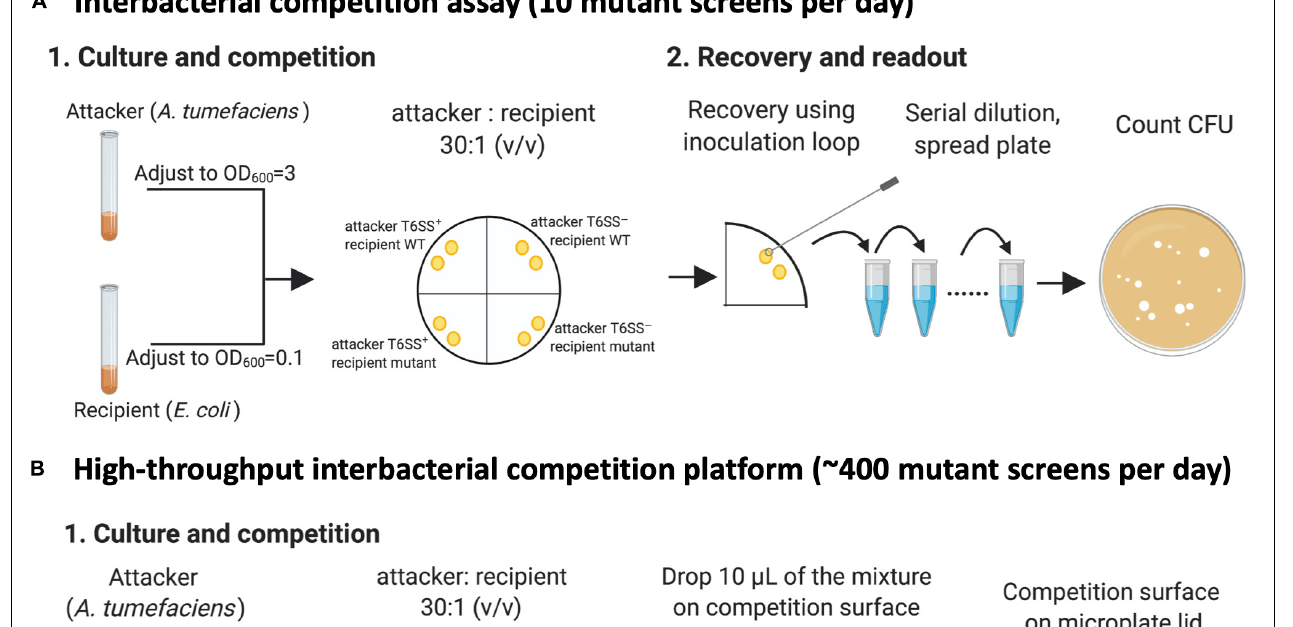
FIGURE 2 | The high-throughput interbacterial competition platform. (A) Interbacterial competition assay. Cultured attacker Agrobacterium tumefaciens and recipient Escherichia coli were mixed and then spotted on the Agrobacterium Kill (AK) agar medium to allow interbacterial competition for 16 h at 25 ◦ C followed by recovery of mixed cultures, serially diluted, and then spread onto lysogeny broth (LB) plate supplemented with appropriate antibiotics to select for recipient cells. (B) High-throughput interbacterial competition screening platform. Recipient cells were grown and mixed with attacker A. tumefaciens in a 96-well plate. The bacterial mixture was dropped onto the AK agar medium competition surface using an automated pipetting system. The competition surface was made on a microplate lid. Recovery was performed using microplate replicator. The candidates are the strains that show multiple colonies grown after recovery as opposed to wild-type controls and most strains with no or few colonies. This high-throughput A. tumefaciens type VI secretion system (T6SS) killing platform enables ∼ 400 mutant screens per day. This figure was created with BioRender (https://biorender.com/).